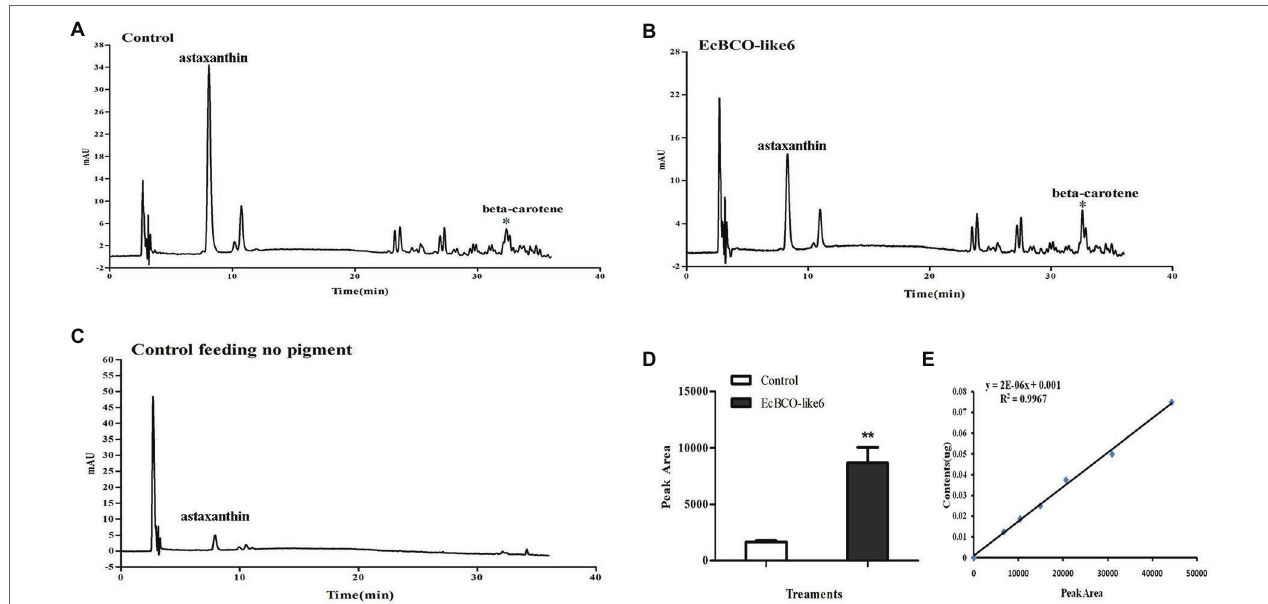
FIGURE 6 | High-performance liquid chromatographies (HPLCs) and the standard curve of beta-carotene. (A,B) show the HPLC analysis of control group feeding the same pigment and the group dsEcBCO-like6 injected, respectively; (C) shows the HPLC analysis of group without any pigment; (D,E) show the peak area and the standard curve of beta-carotene content. The main difference between the control group and EcBCO-like6 group was the peak area of beta-carotene. All samples were analyzed in three biological triplicates. Asterisks ( ** ) indicate extremely significant differences ( p < 0.01) of the peak area between EcBCO-like6 group and control